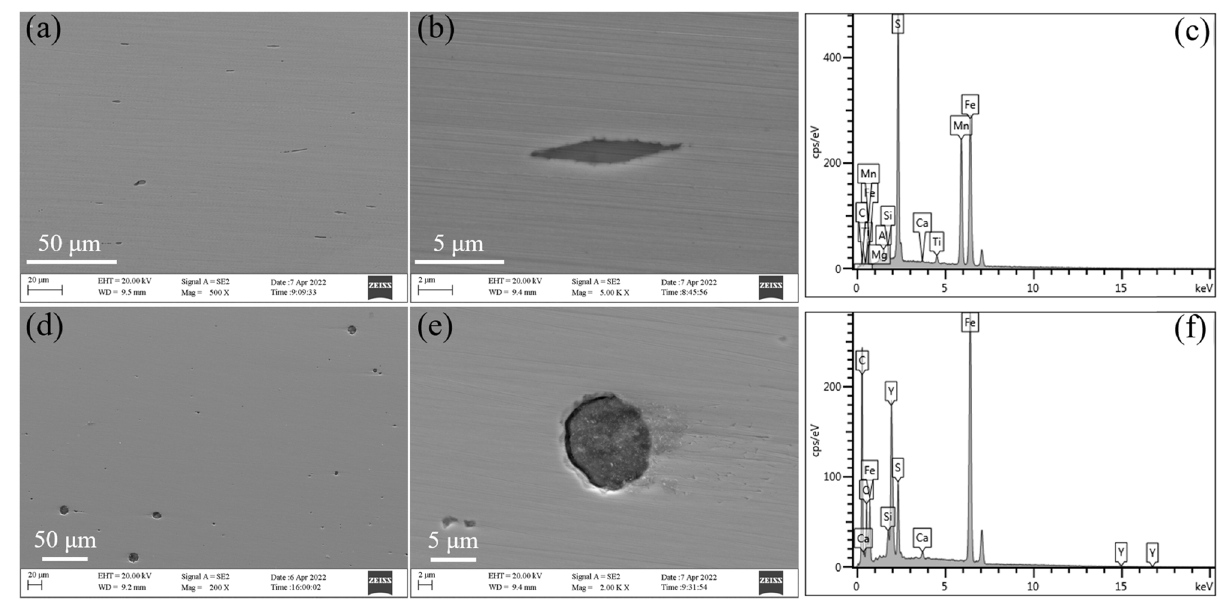
Figure 2: Large inclusions in silicon steels: ( a – c ) Y - free steel and ( d – f ) Y - bearing